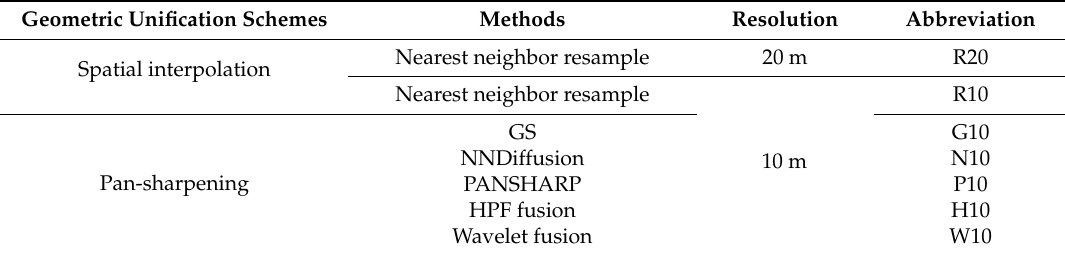
Table 1. Data sets generated by